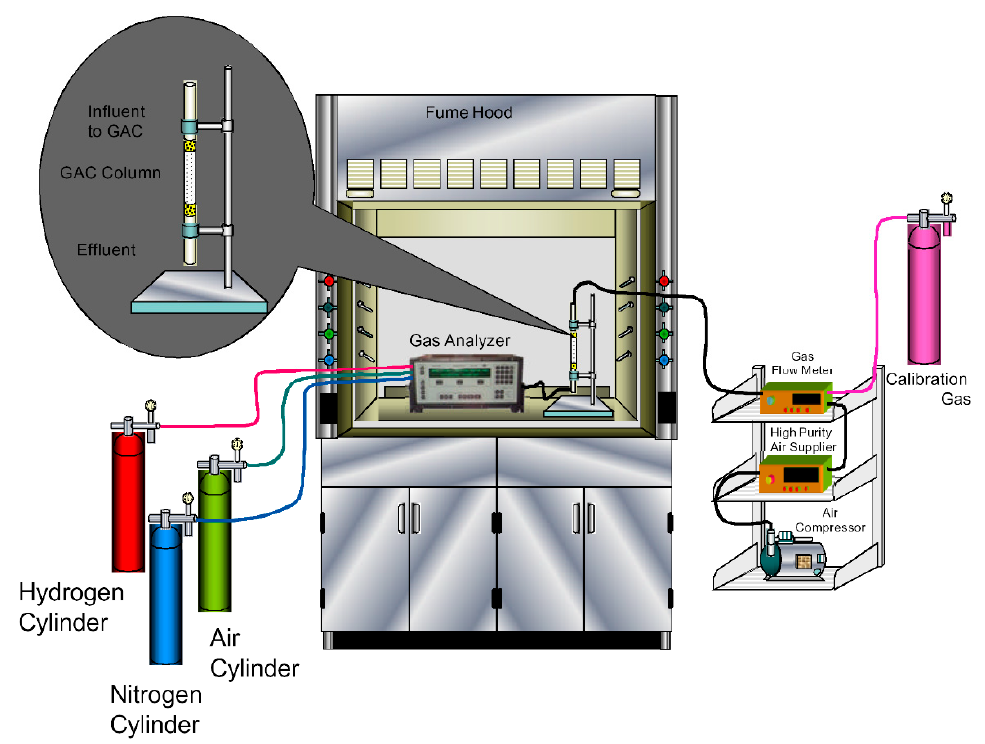
Figure 1. The experimental setup used for the dynamic continuous toluene gas flow adsorption experiments.